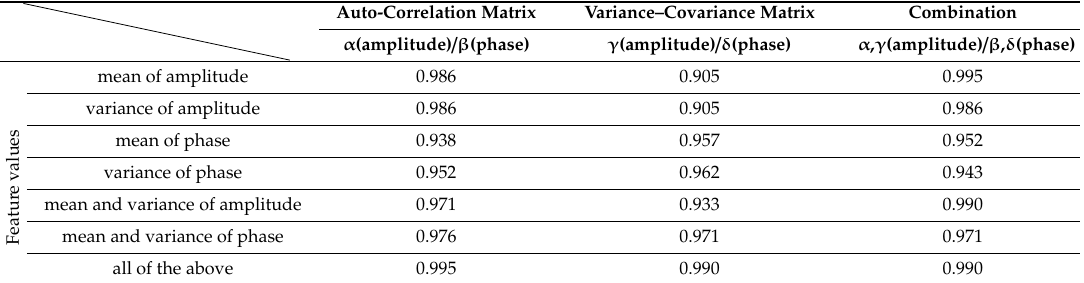
Table 3. Prediction accuracy for two directions when using the length of the final passing section and CSI. The values denote the predicted